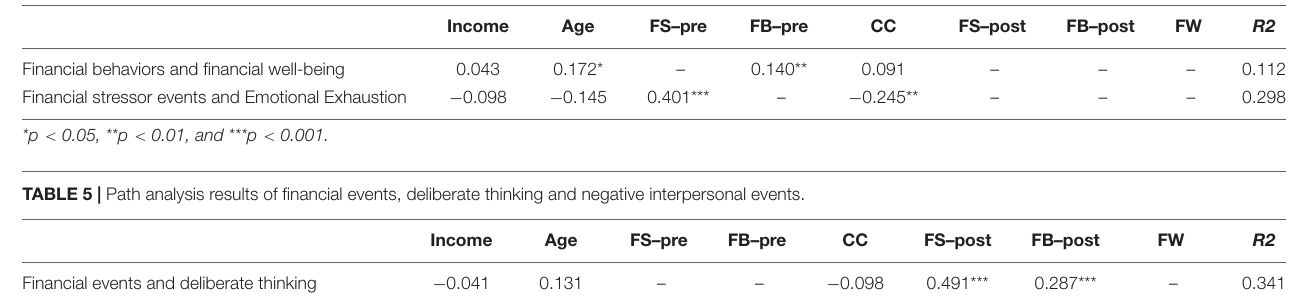
TABLE 4 | Path analysis results of financial behavior, financial well-being, financial events, and emotional exhaustion.